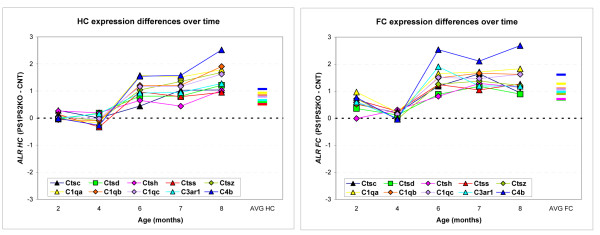
PS ablation-dependent expression changes in cathepsin and complement transcripts as a function of postnatal age. The expression changes of 5 cathepsin (Ctsc, Ctsd, Ctsh, Ctss and Ctsz) and 5 complement system transcripts (C1qa, C1qb, C1qc, C3ar1 and C4b) were examined in more detail. In both graphs X axis denotes age of mice, while Y axis denotes pairwise expression difference between the PSKO mice and matched WT samples. Each color line represents change in expression over time for a single gene. A) FC. B) HC. Note the similarity of the age-dependent transcript increase in the PSKO animals across the two brain regions.